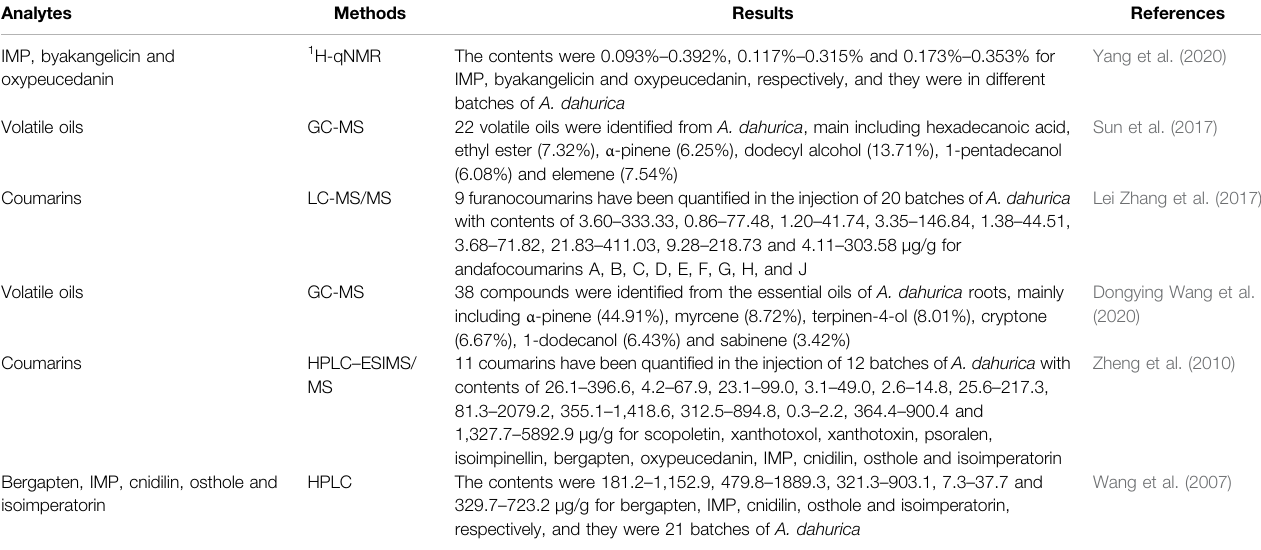
TABLE 6 | Quantitative analysis for the quality control of A. dahurica